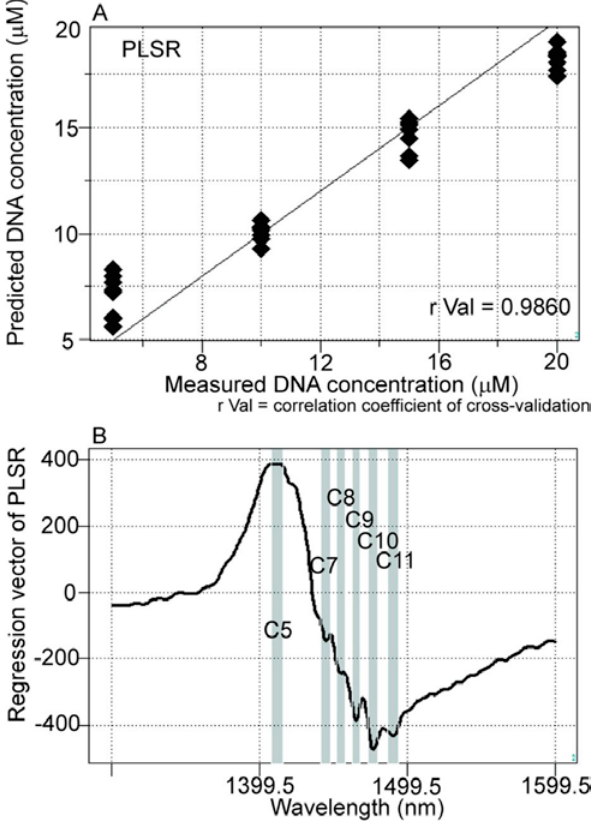
Figure 10. NIRS regression model for DNA concentration. (A) Y-fit for DNA concentration of partial least squares regression (PLSR) with pretreatment by mean centering, smoothing (21 points), orthogonal signal correction (OSC) (one component), and active class validation. N = 32, number of applied latent vari- ables = 2, rCal = 0.9978, SEC = 0.3882, rVal = 0.9860, SECV = 1.5131. (B) Regression vector of the PLSR calibration model for DNA con- centration showing characteristic water peaks at the 1400–1500 nm spectral interval.